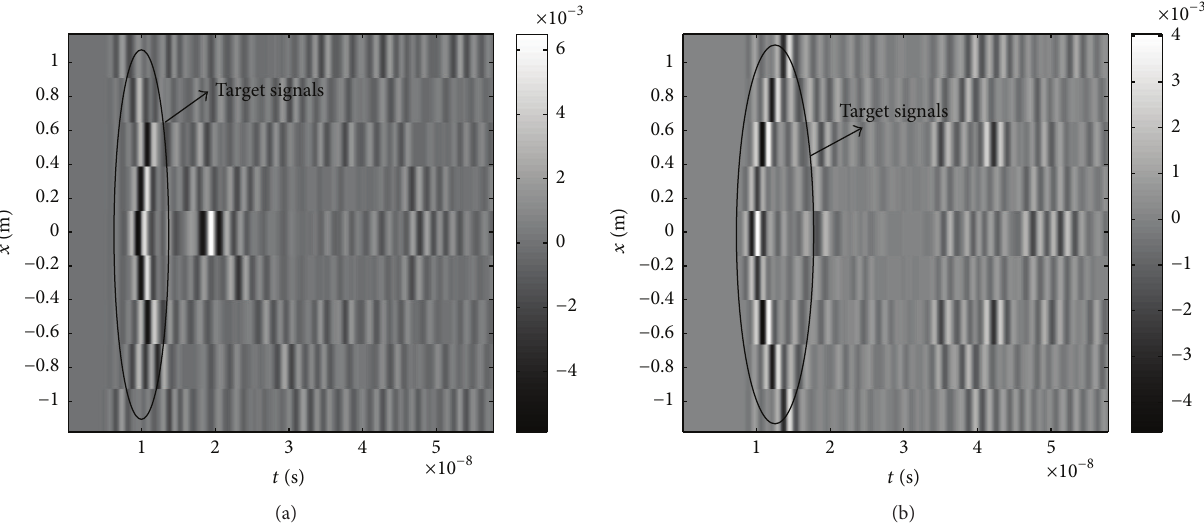
Figure 5: B-scan data for the target scattering fields based on (a) the proposed method and (b) background